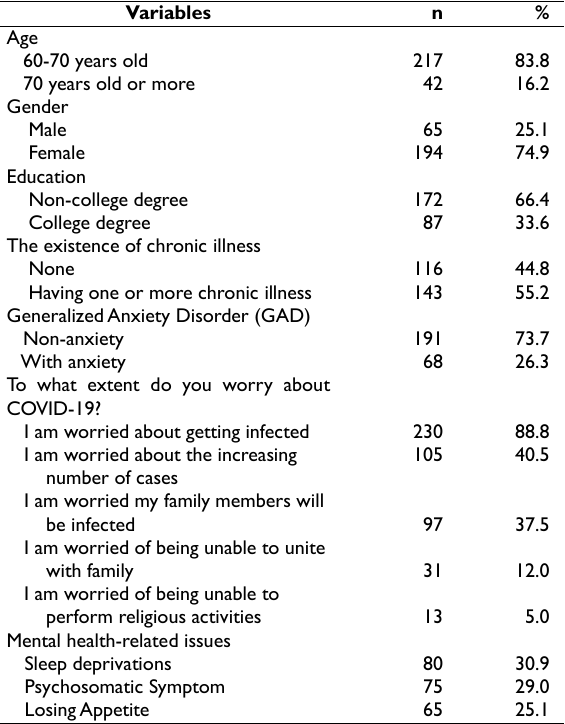
Table 1 Sociodemographic characteristics of the participants (N = 259) Variables